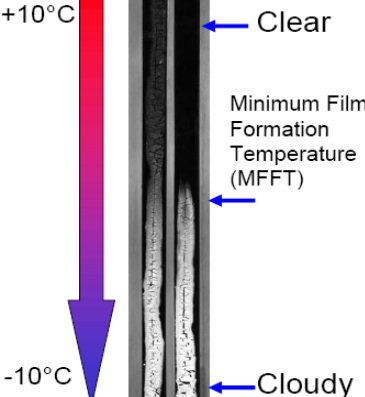
Fig. 6. Pselecta MFFT tester device